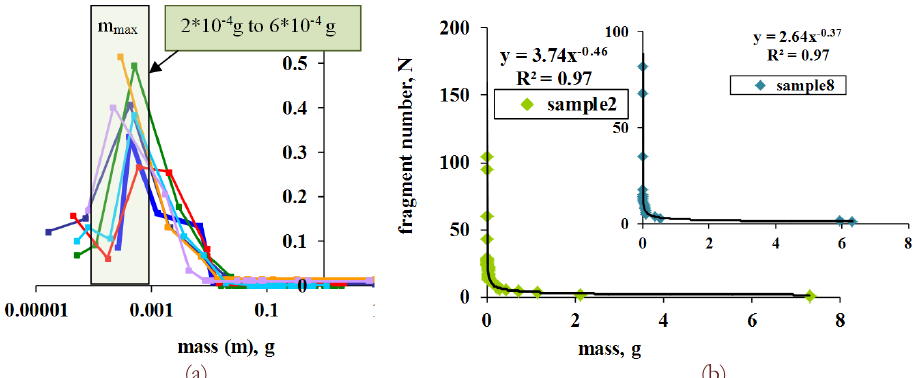
Figure 5: a) Probability density function (different colors correspond to different samples). b) Cumulative fragment size